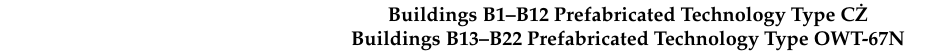
Table 1. Basic technical parameters of the surveyed